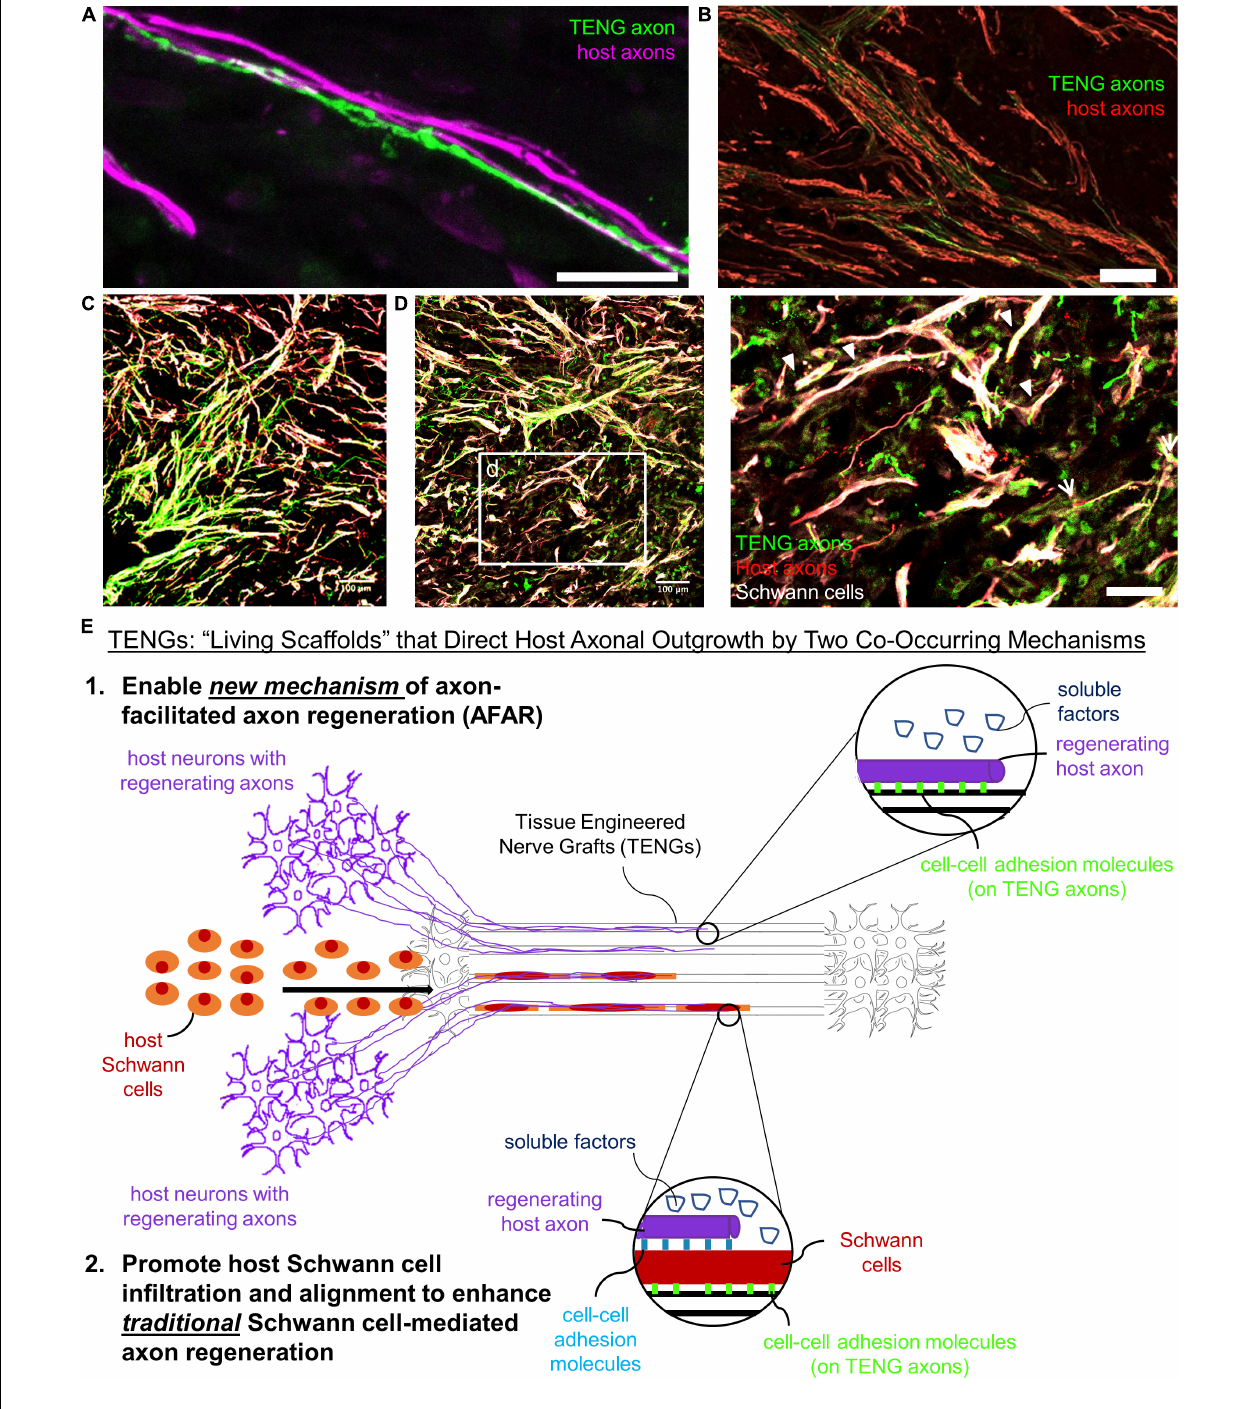
FIGURE 7 | TENGs Mechanisms-of-Action: The Value of Axons. Host axons favor paths created by transplanted TENG axons. TENGs serve as a living scaffold to facilitate regeneration via AFAR on the level of both (A) individual axons (scale bar: 100 µ m) and (B) groups of axons (scale bar: 50 µ m). (C,D) Tripartite regenerative mechanism: integration of TENG axons with both host axons and host SCs (scale bar: 100 µ m). (d) Inset image from (D) showing colocalization of TENG axons with host axons and host SCs. TENGs enhance SC alignment as pointed out by the arrowheads, which then facilitate host axon growth. The arrows show instances of direct AFAR, illustrated by colocalization of TENG and host axons without the presence of host SCs (scale bar: 50 µ m). (E) Conceptual schematic depicting the MoA of TENGs, leading to synergistic presentation of neurotrophic, chemotaxic and haptotaxic cues only possible with a “living scaffold.” Overall, TENGS possess novel mechanisms compared to NGTs & autografts: direct AFAR (not possible with autograft), increased SC infiltration and alignment (versus NGT), and robust presence of “leading regenerator” axons (versus NGT). This AFAR – unique to TENGs – compliments traditional SC-mediated axon regeneration.